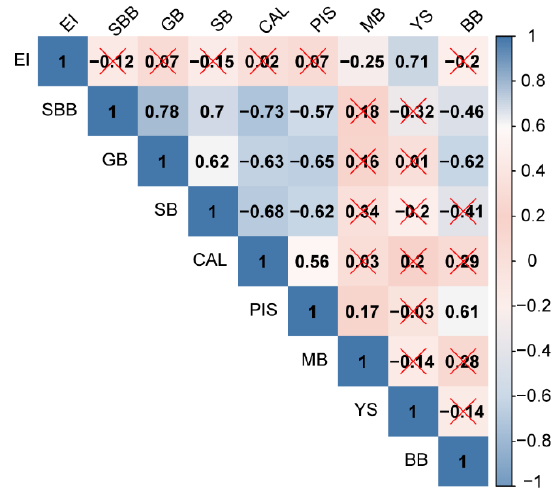
Figure 3. Spearman’s correlation matrix in the scale deposition rate (SDR) from sites in the Pan-Pacific. The numbers indicate value of correlation coefficient, and the red X shows that the significance test of p < 0.05 failed. YS: Yellow Sea; BB: Beppu Bay; EI: Effingham Inlet; SBB: Santa Barbara Basin; GB: Guaymas Basin; SB: Soledad Basin; CAL: Callao; PIS: Pisco; MB: Mejillones